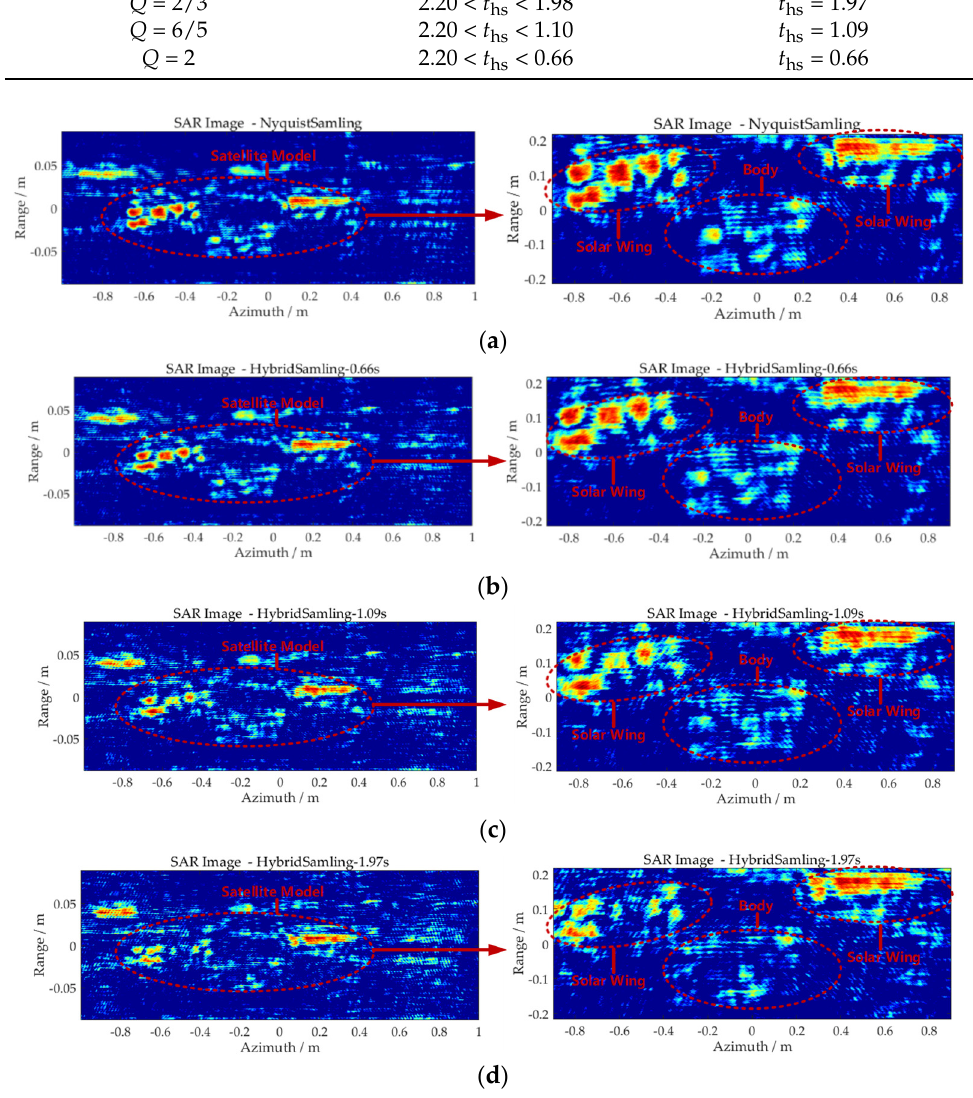
Figure 9. The SAR experimental imaging results of satellite model target with different Q factors: ( a ) Nyquist real-time sampling; ( b ) Q = 2, t hs = 0.66 s; ( c ) Q = 6/5, t hs = 1.09 s; ( d ) Q = 2/3, t hs = 1.97 s.